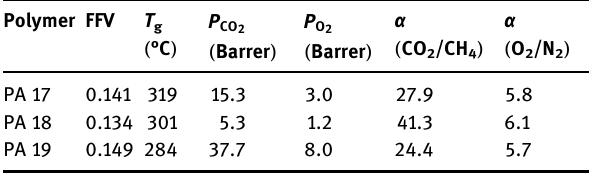
Table 4: Speci fi c volume, T g , hole a ffi nity constant ( C H ) , gas per - meability ( in Barrers ) , and permselectivity values of the PAs with varied number of bulky tert - butyl groups at 1 atm upstream pres - sure and 35°C ( 62 )